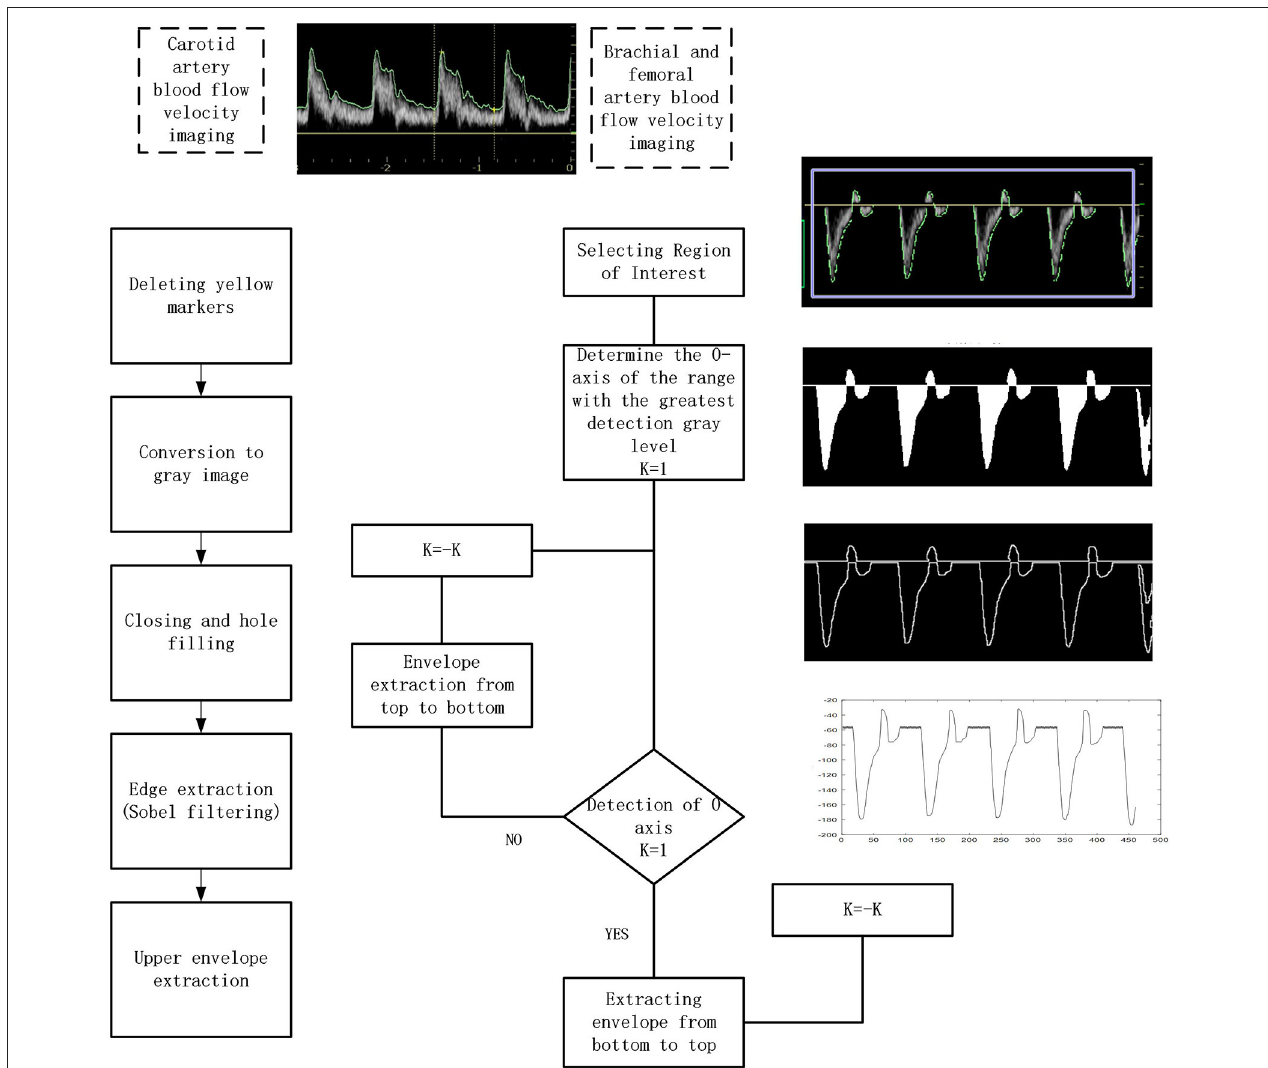
FIGURE 1 | Flowchart of the image